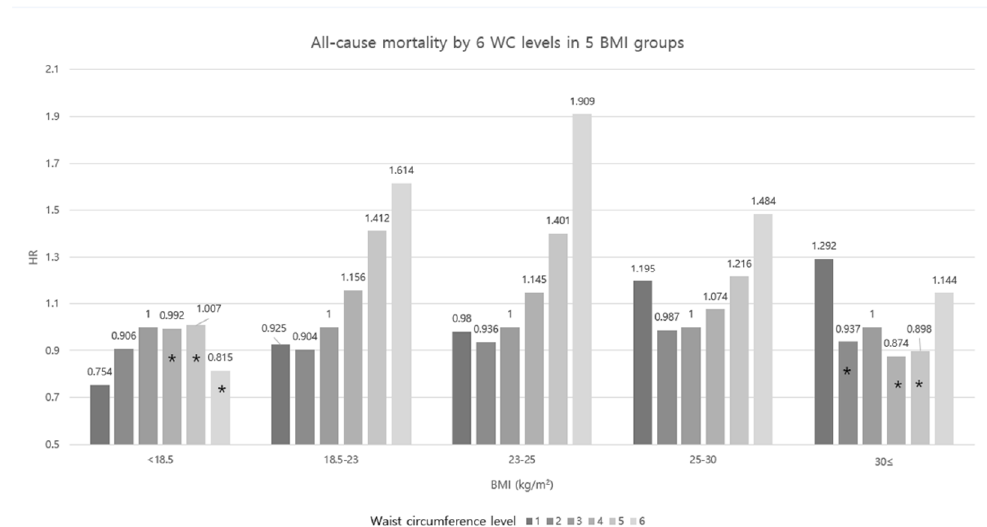
Figure 2. All-cause mortality by waist circumference and BMI. Adjusted for age, sex, smoking, drinking, exercise, income, and body mass index. WC: waist circumference, HR: hazard ratio, and BMI: body mass index. * Statistically not significant.